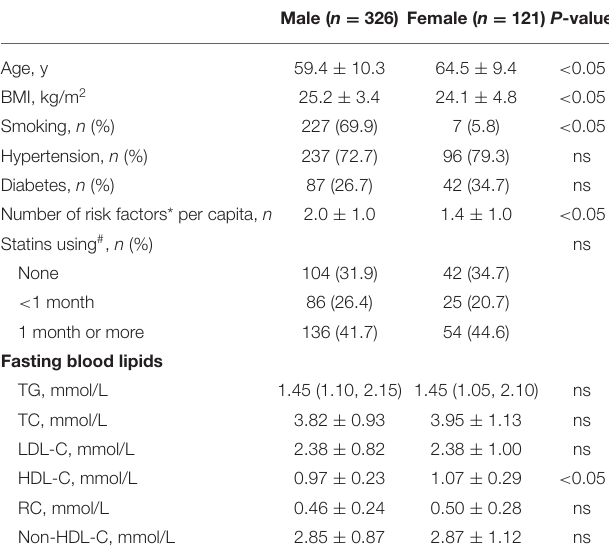
TABLE 1 | Clinical characteristics of patients with CHD between male and